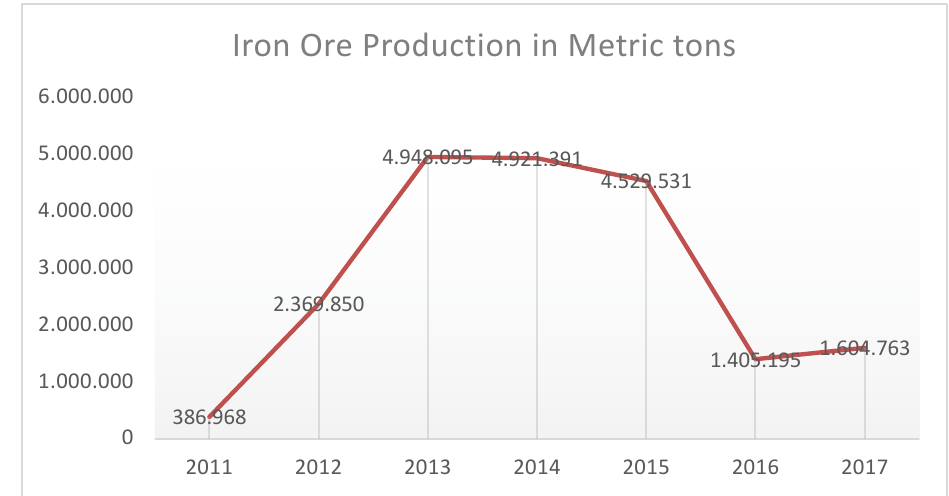
Figure 4: Production of iron ore in tonnes from 2011 to 2017 in Liberia (CBL Annual Report, 2010-